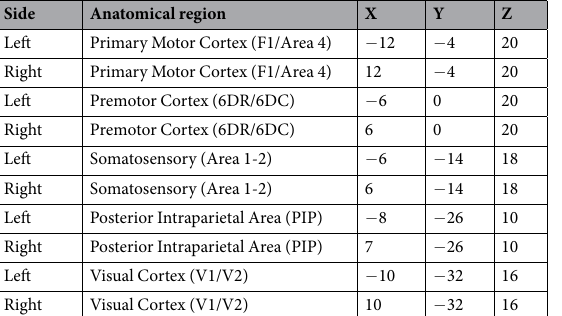
Table 1. Anatomical location of seed for functional connectivity analysis. Coordinates in MNI space from cynomulgus macaque atlas template in